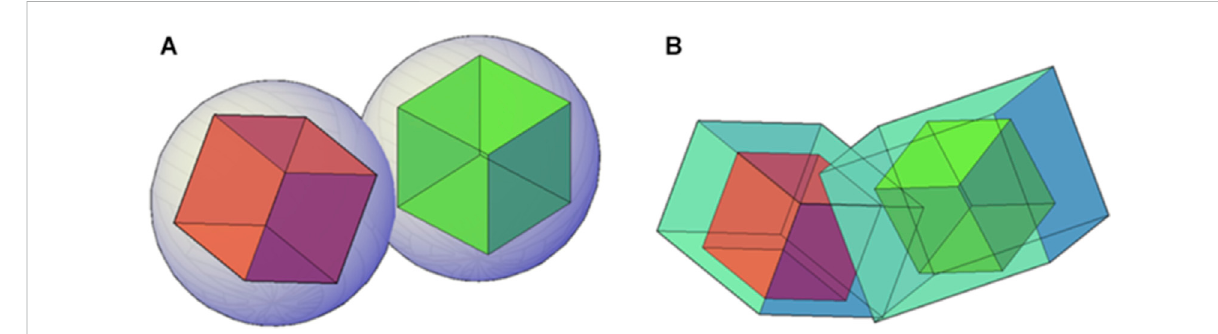
FIGURE 2 Neighbor particles contact detected search: (A) bounding spheres; (B) OBB.